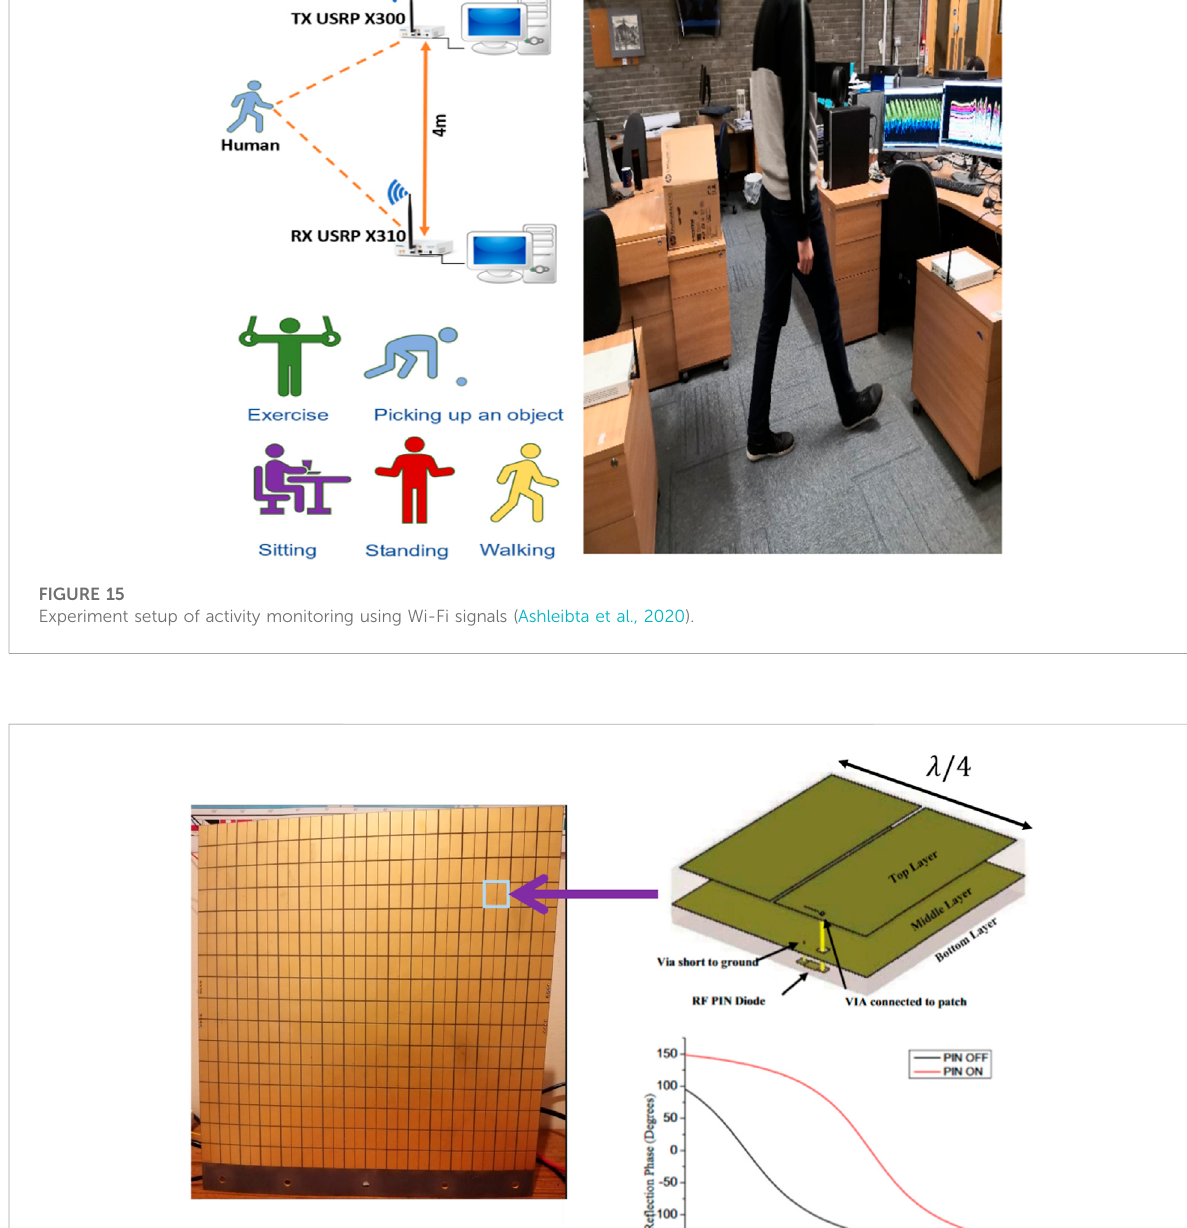
Frontiers in Communications and